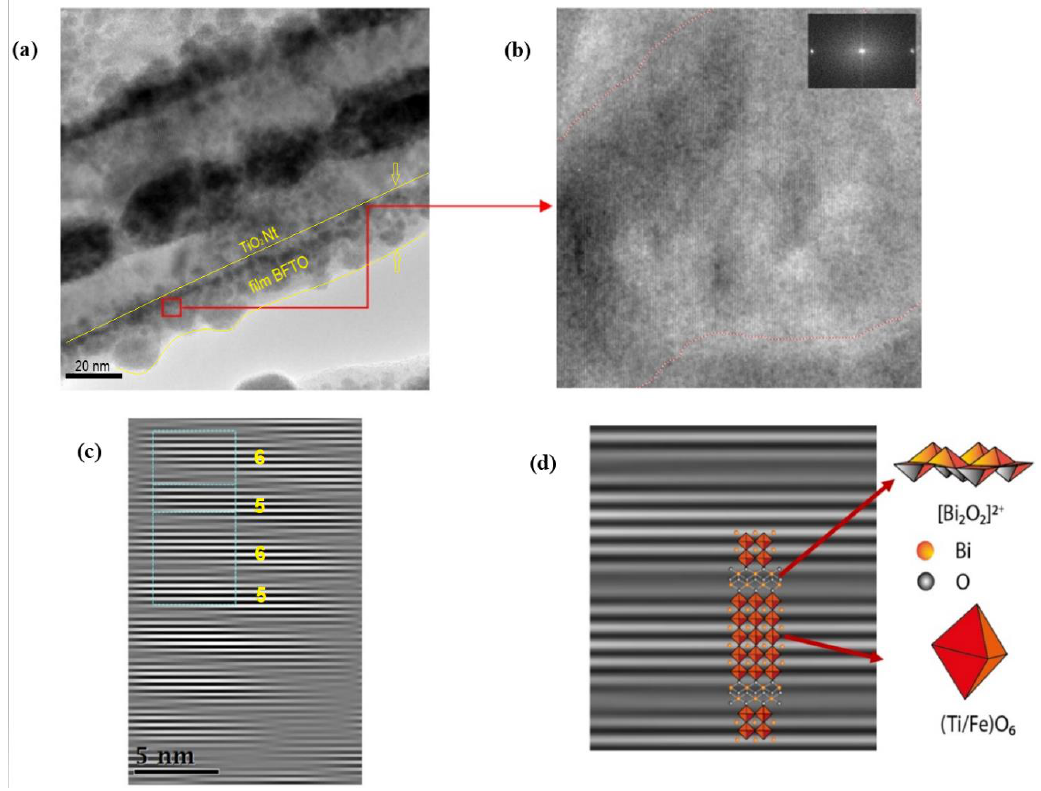
Figure 3. Transmission electron microscopy (TEM) analysis: ( a ) image of an ALD-coated single TiO 2 Nt, ( b ) enlarged area (7 × 7 nm 2 ) near the nanotube–film interface where the layered structure is visualized and ( c , d ) Fourier masked micrographs of the layered structure region.